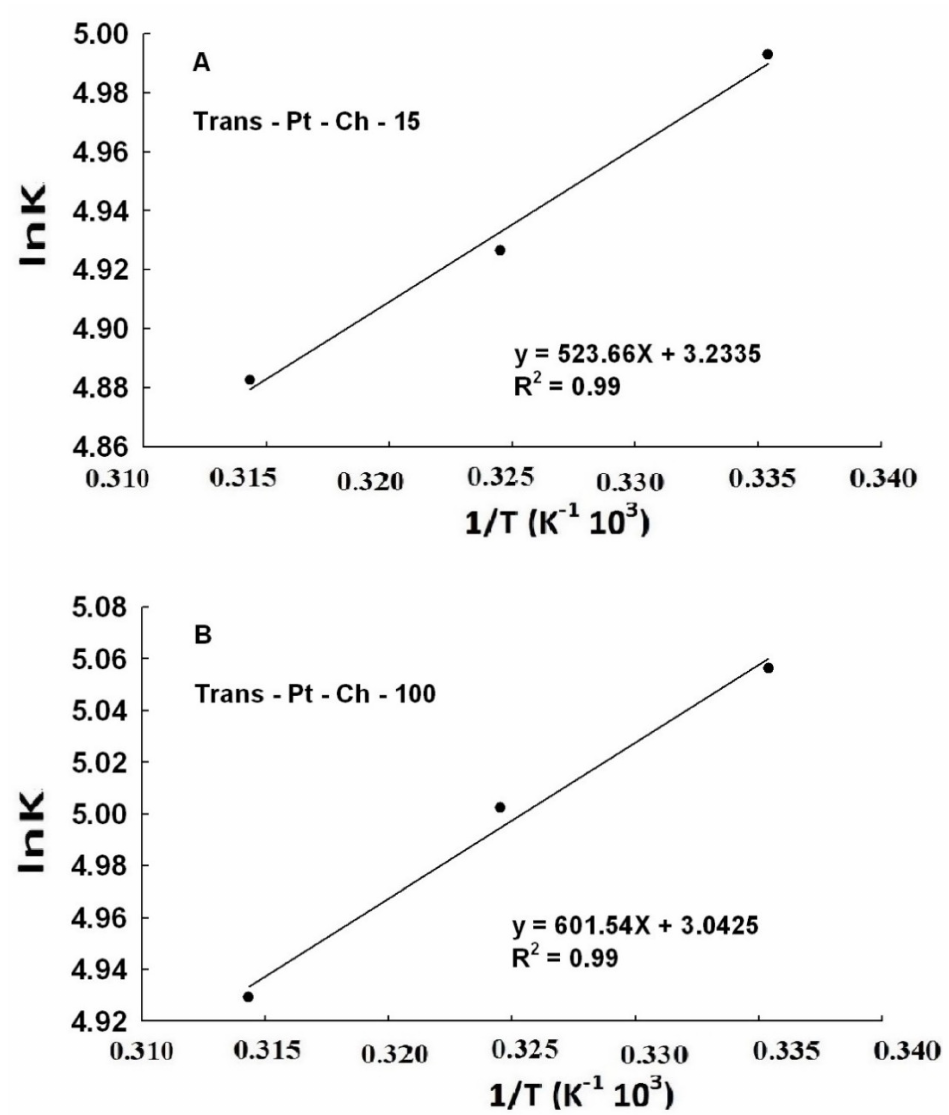
Figure 4. lnK vs. 1/T for chitosan with trans–Pt conjugates: ( A ) Trans–Pt–Ch–15; ( B )